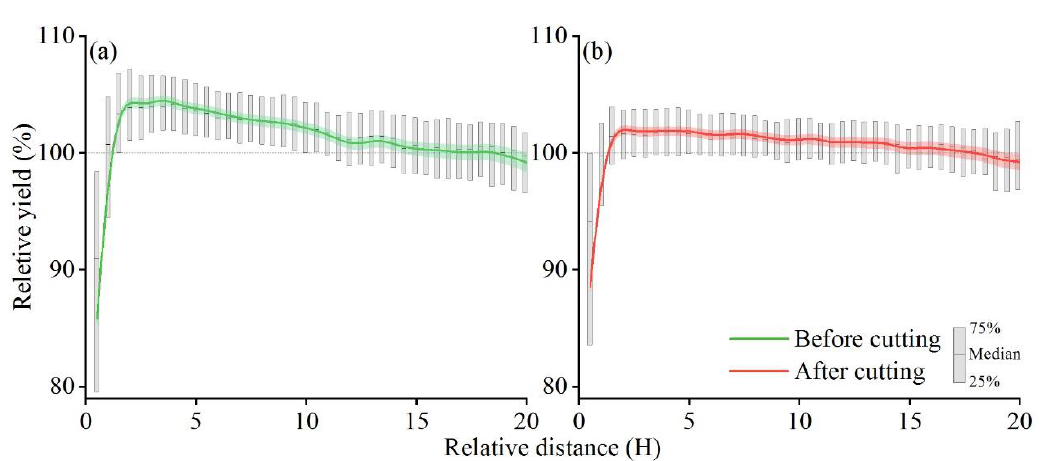
Figure 3. The relative yield profiles before ( a ) and after ( b ) shelterbelt cutting. Boxes show the quartile values from 25% to 75% of the relative yield with horizontal lines for the median. The shadow represents the 95% confidence interval.